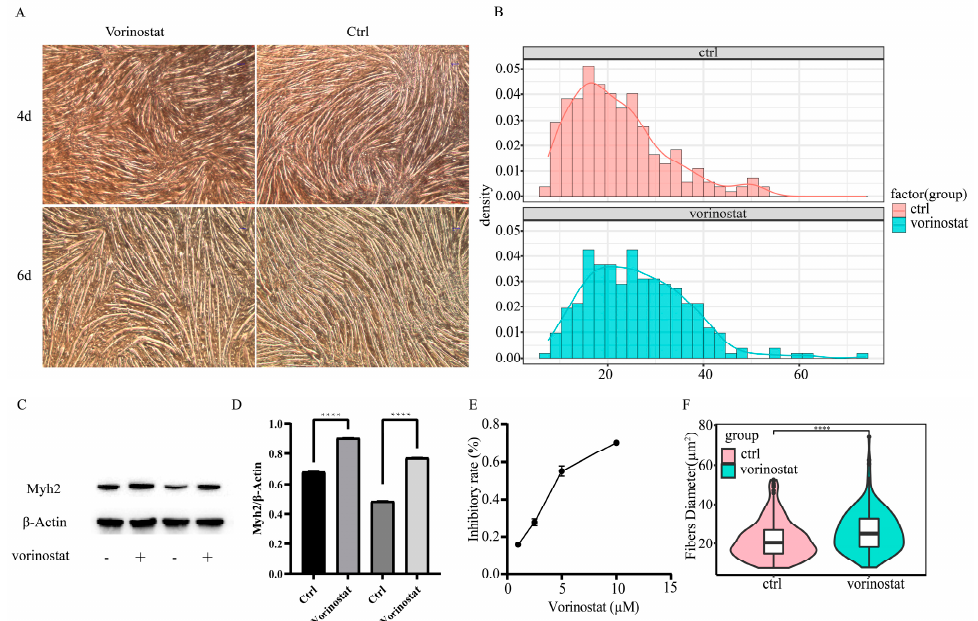
ing with pathway enrichment analysis.